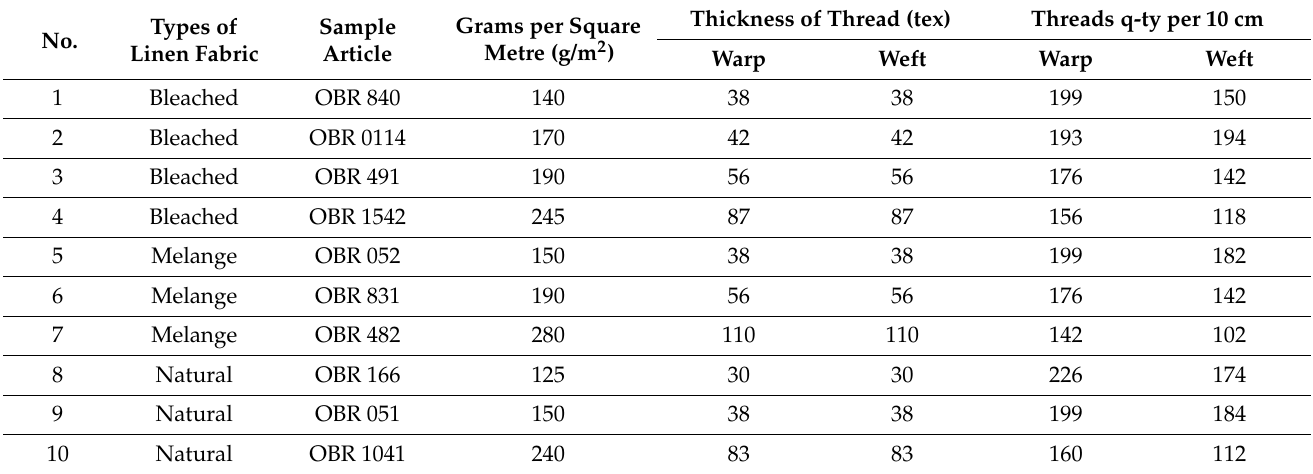
Table 1. Linen fabrics selected for investigation.